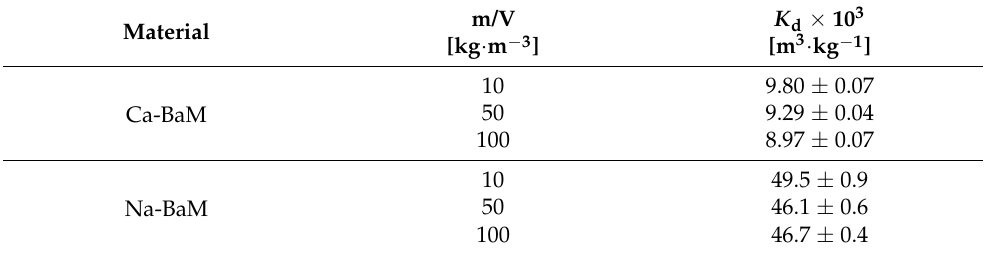
Table 1. Obtained K d values from batch sorption experiments with Sr on loose Ca- and Na-bentonite.